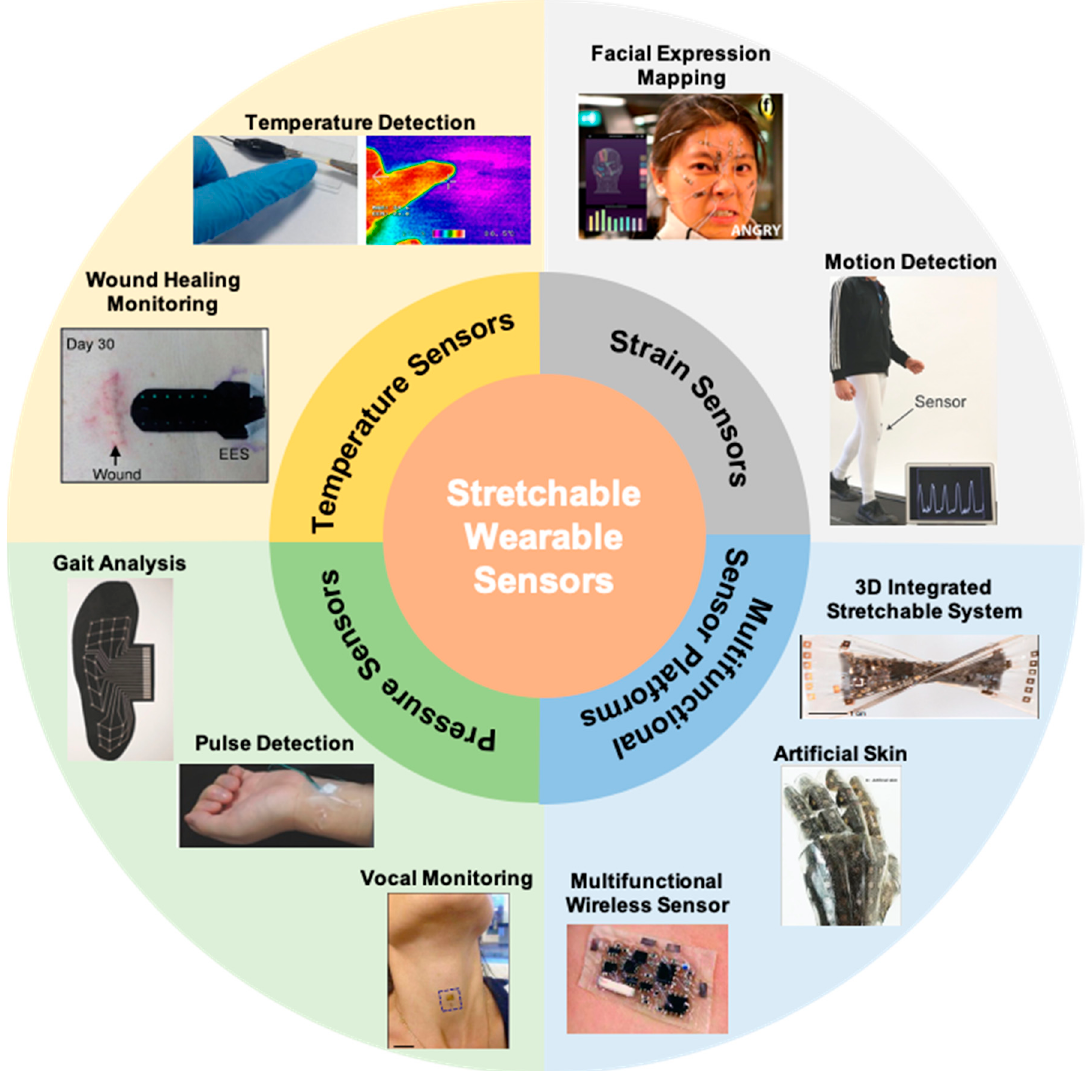
Figure 1. Illustration of recently developed wearable mechanical sensors. Temperature